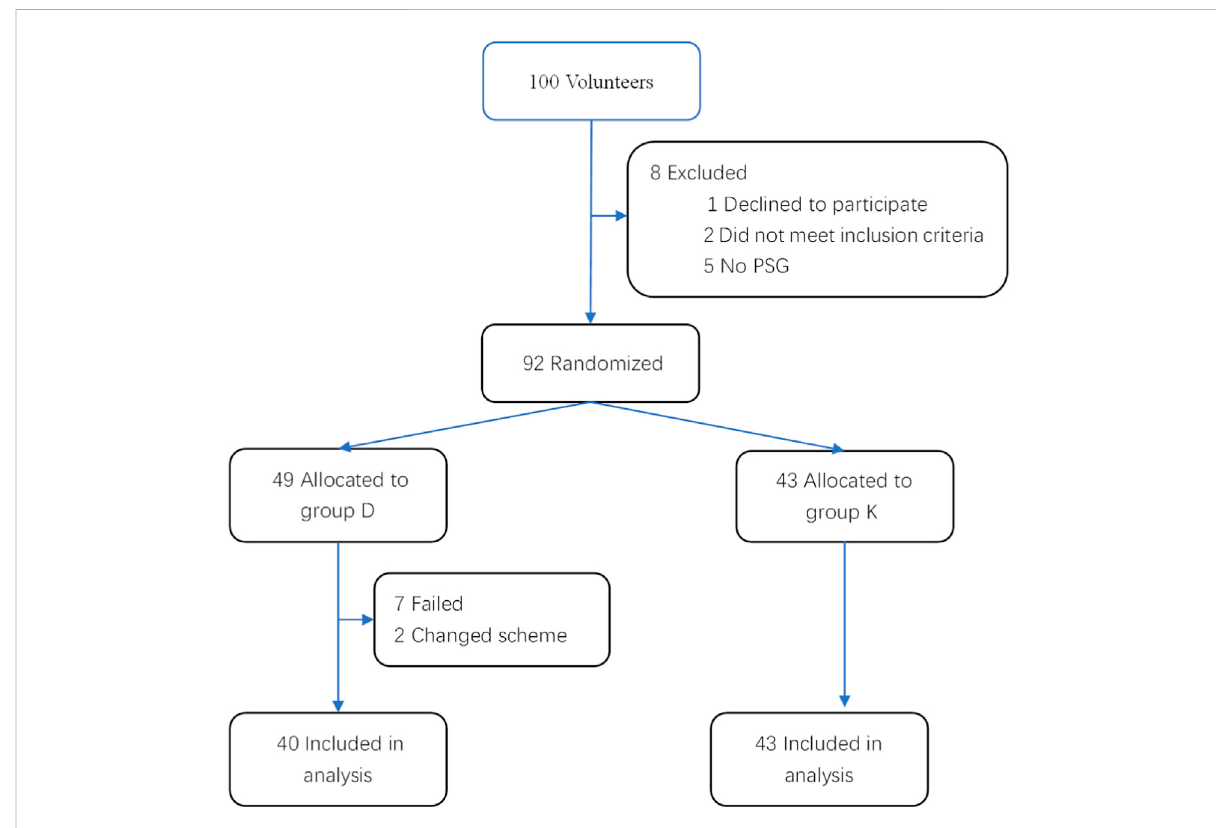
FIGURE 1 Flow diagram illustrating patients ’ enrollment throughout the